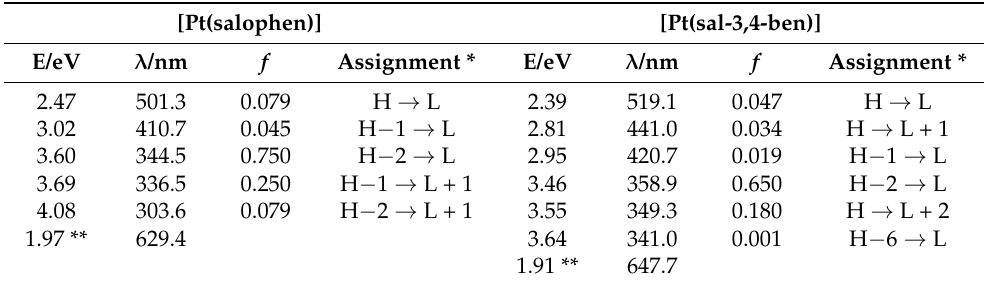
Figure 3. ( a ) NTOs hole/particle pair densities for the first triplet excited states of [Pt(salophen)] and [Pt(sal-3,4-ben)] in a vacuum at the PBE0/(def2-TZVP(C,N,O,H) and SARC-ZORA-def2-TZVP- Pt(II) atom) level (green and red colors represent the different density parities); ( b ) experimental OLED energy level diagram (inside the PFO energy diagram: blue represents [Pt(salophen)] and red represents [Pt(sal-3,4-ben)]). Table 2. Theoretical energy excitations of [Pt(salophen)] and [Pt(sal-3,4-ben)], calculated in the DFT/TD-DFT framework at the PBE0/(def2-TZVP(C,N,O,H) and SARC-ZORA-def2-TZVP-Pt(II) atom) level in a vacuum (* larger contributions, ** first triplet